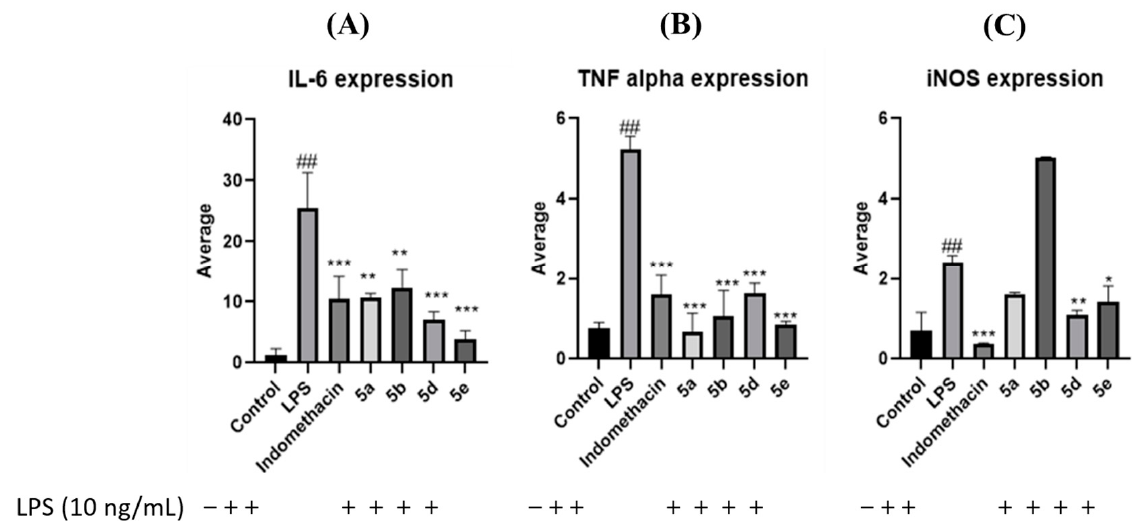
Figure 5. Expression levels of IL-6 ( A ), TNF- α ( B ), and iNOS mRNA ( C ) in LPS-stimulated RAW264.7 macrophages. A concentration of 40 µ g/mL of indomethacin (positive control), 5a , 5b , 5d , and 5e was used for the treatment of LPS-stimulated RAW264.7 macrophages (10 ng/mL). The RT-qPCR was used to measure mRNA levels of IL-6, TNF- α , and iNOS using the comparative method (2 − ∆∆ CT ). Significant differences indicated in the graphs are all in comparison to LPS-stimulated cells only (designated as ##). Values are means ± S.D. ( n = 3). * p < 0.05, ** p < 0.001, *** p < 0.001.